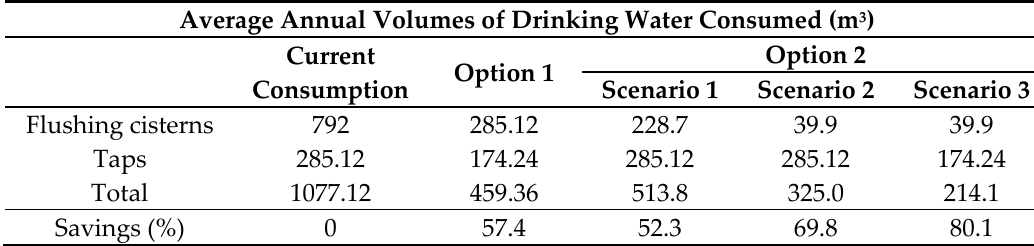
Table 2. Average annual volumes of water consumed and savings potential.